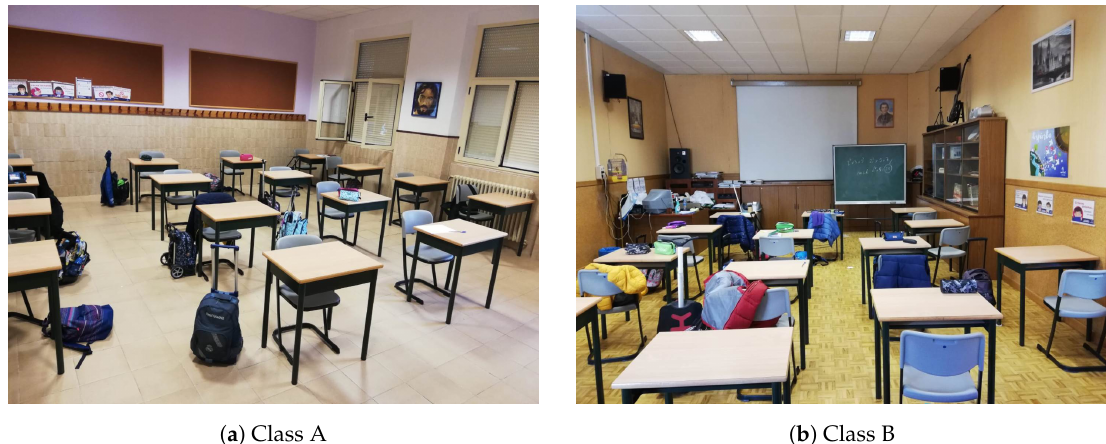
Figure 1. Picture of both classrooms from the Marist Brothers School San José, used for the scenario modeling and optimization in this paper.